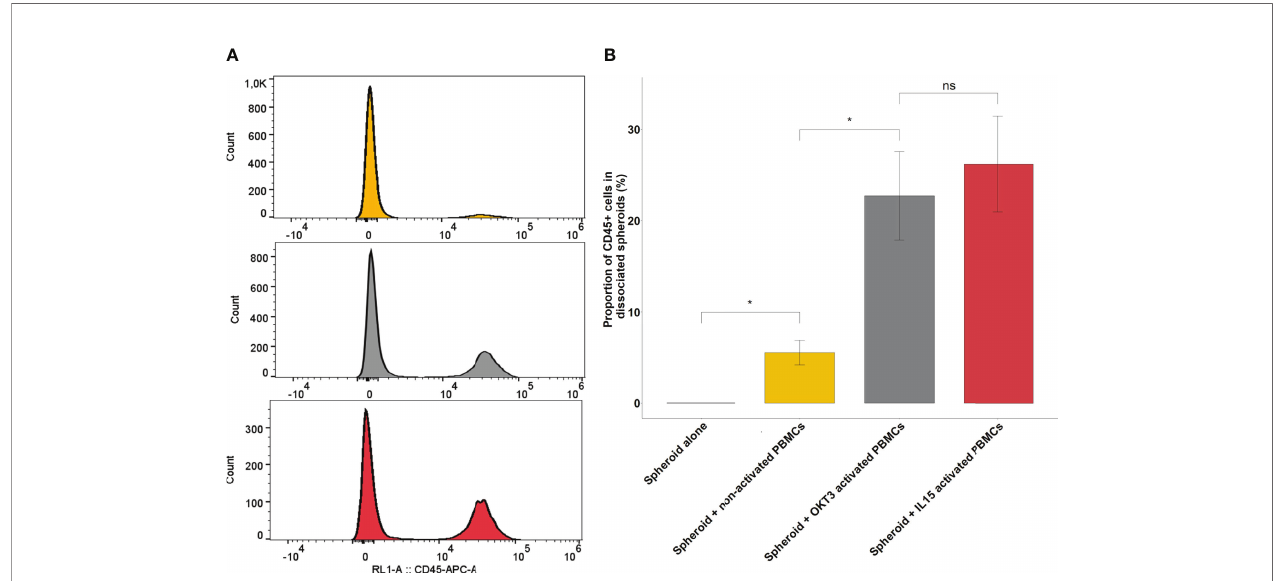
FIGURE 4 | Immune in fi ltration following co-culture between RCC spheroids and activated or non-activated PBMCs. (A) Representative CD45 fl ow cytometry histograms of 3 pooled, washed and dissociated spheroids after 24h of culture, alone, in co-culture with non-activated PBMCs or with PBMCs activated with IL-15. (B) Barplots representing the percentage of CD45 positive cells found by fl ow cytometry in the dissociated spheroid after co-culture in the indicated conditions of activation. Results for a representative experiment out of 3, performed in quadruplicates. Error bars represent standard error, statistical signi fi cance (p<0.05) of the Student test is noti fi ed by a star. *p < 0.05; ns, non-signi fi